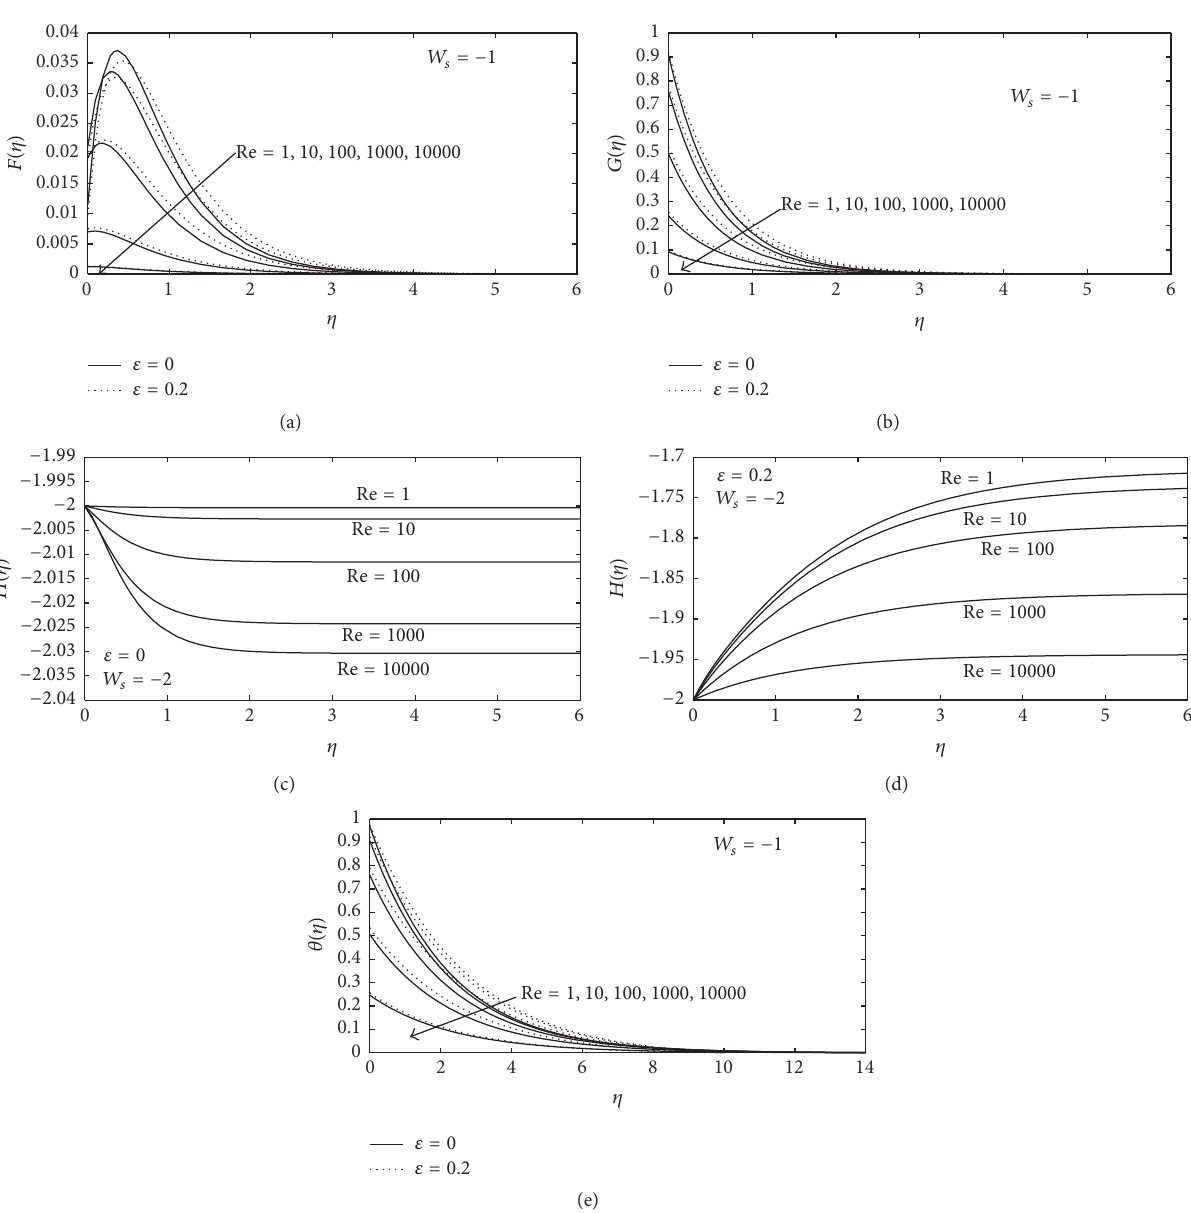
Figure 4: Effect of variation in the Reynolds number on the (a) radial, (b) tangential, (c) & (d) axial, and (e) temperature velocity profiles when 𝐾 = 1 , Kn = 0.05, 𝑁 = 1 , and Pr = 1.